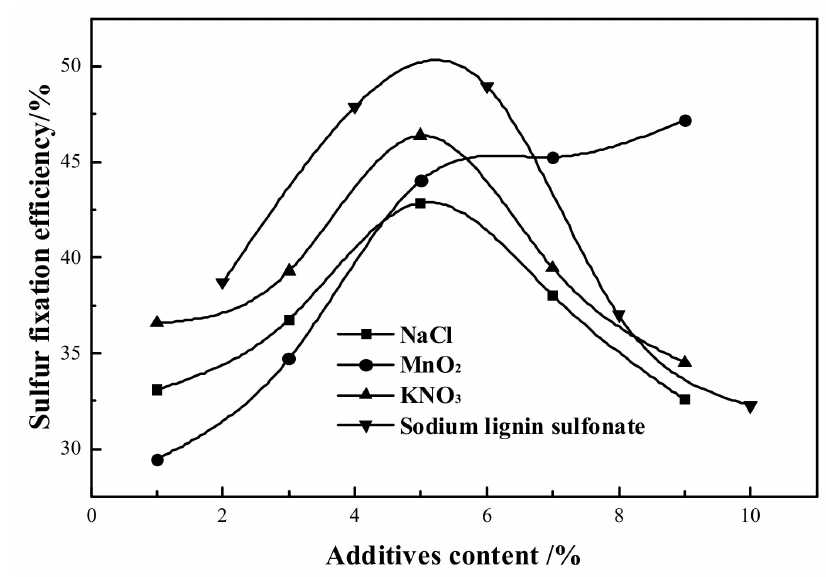
Figure 3. Effect of additive content on sulfur-fixing efficiency.